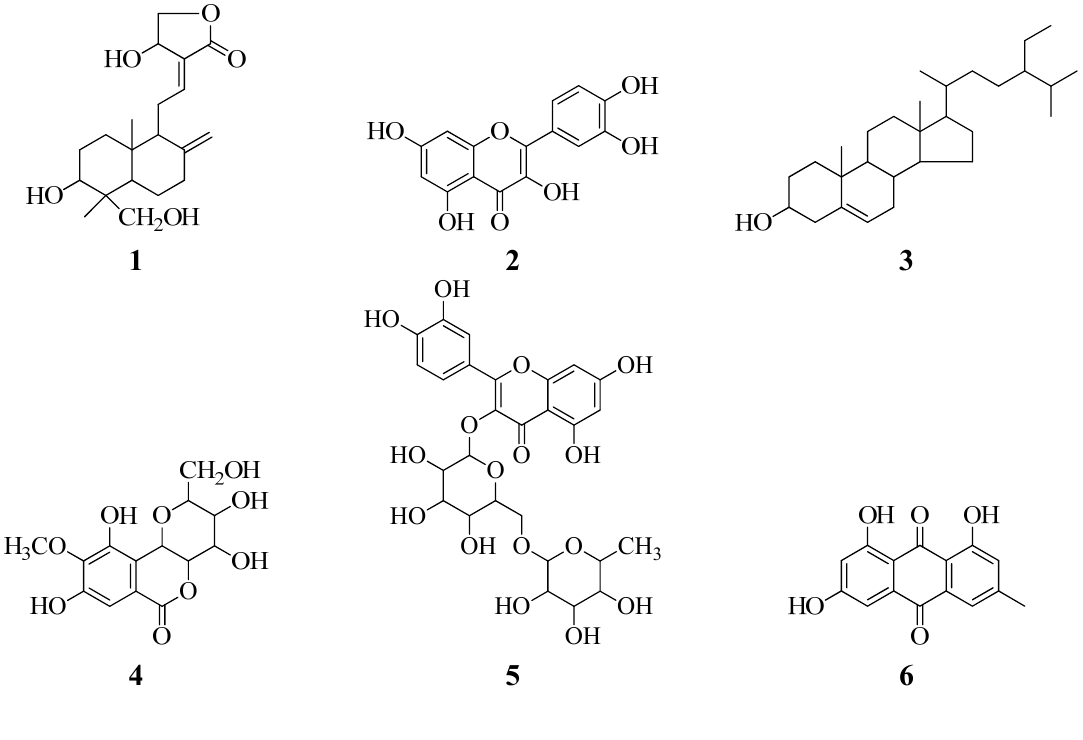
Figure 1. Structures of isolated compounds 1 – 14 and reference substances ADM and